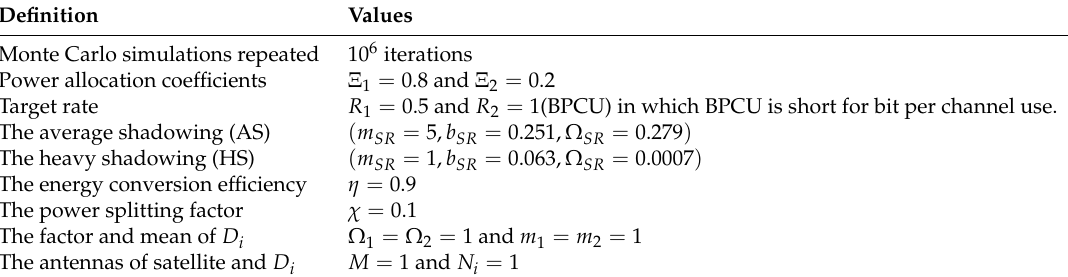
Table 2. Table of parameters for numerical